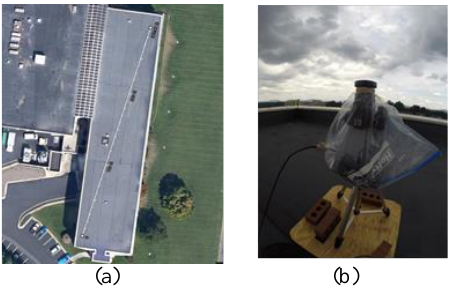
Figure 2. (a) Camera positions on the top of a three story building. (b) Camera installation on the